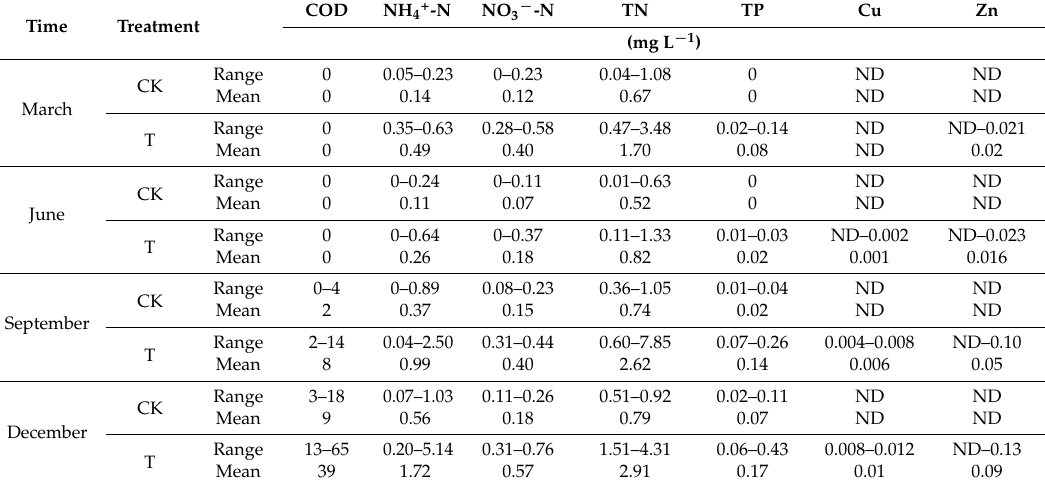
Table 5. Quality of the surface waters in the vicinity of sample pig